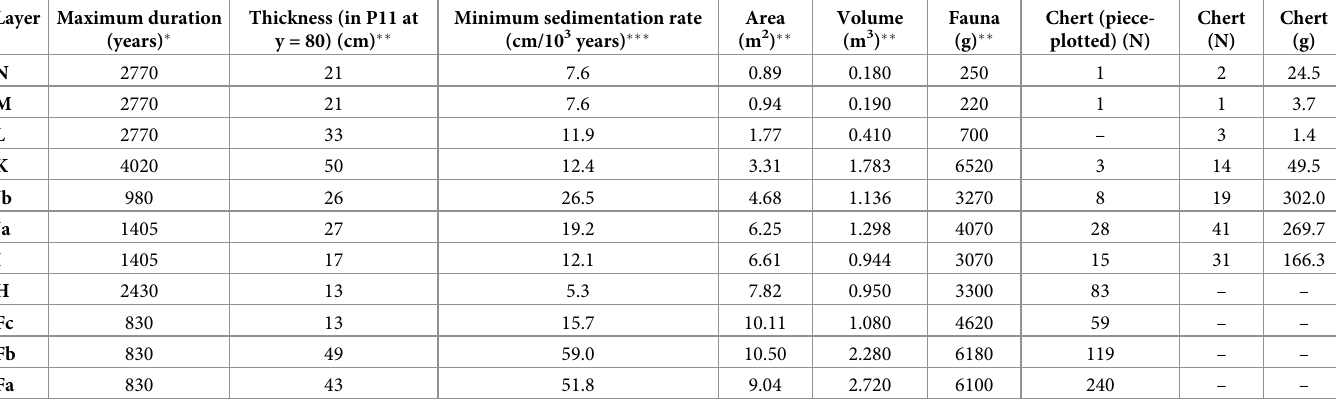
Per stratigraphic unit (Back Chamber and Corridor) � based on the difference between the upper and lower boundaries of the 95.4% probability intervals returned for each unit by Model V (cf. Table O; the maximum durations for L, I, Ja, Fc, Fb and Fa are obtained dividing in equal parts those for L-N, I/Ja and Fa/Fc) �� after [2] and unpublished data ��� thickness in P11 divided by maximum duration of the